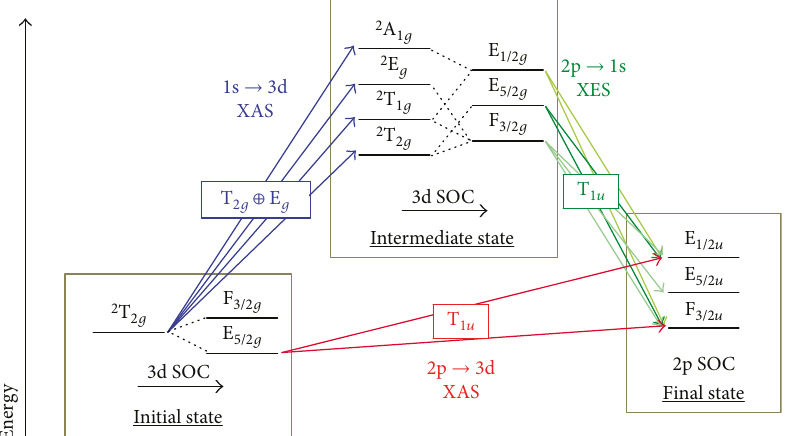
Figure 42: Multielectronic term scheme for Fe 3+ ( 3d 5 ) low spin comparing the 1s2p RIXS and direct 2p XAS pathways. Where SOC is considered, the spin multiplicity was